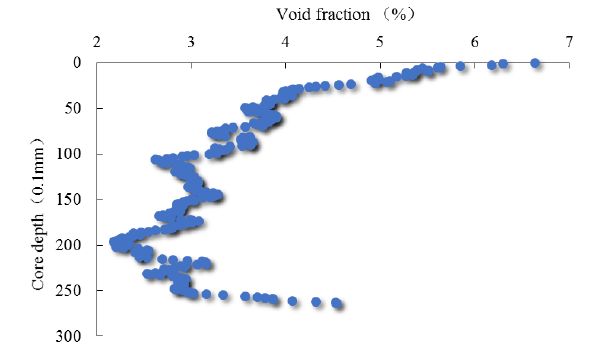
Fig. 2 Image segmentation by OSTU method with the circular block (5 loops).